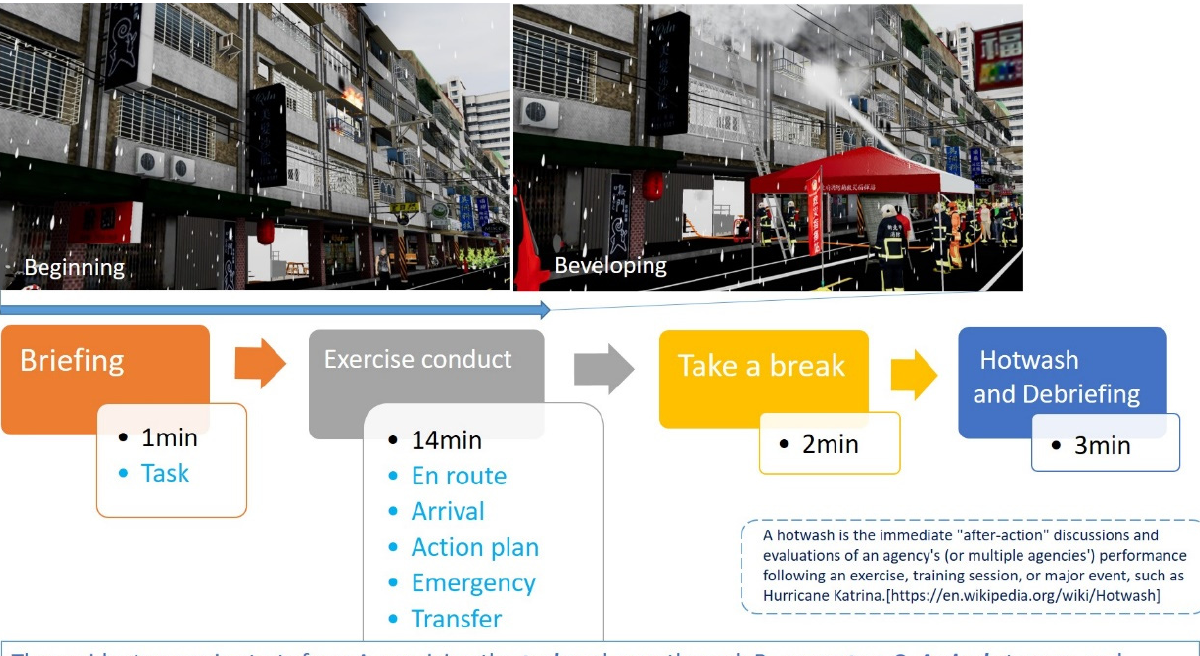
Figure 6. The two different types of buildings in this experiment’s fire simulation.